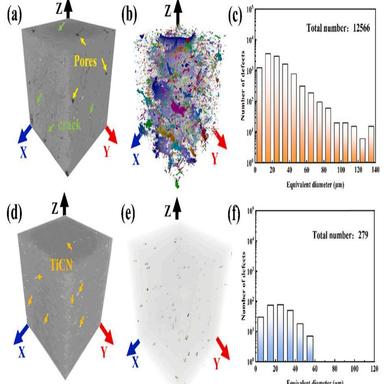
Densification behavior of as-built samples, CT 3D-reconstruction images showing the surface and internal defects distribution of (a–c) pure 2024 Al alloy, and (d–f) 2024-5 vol% TiCN composite.